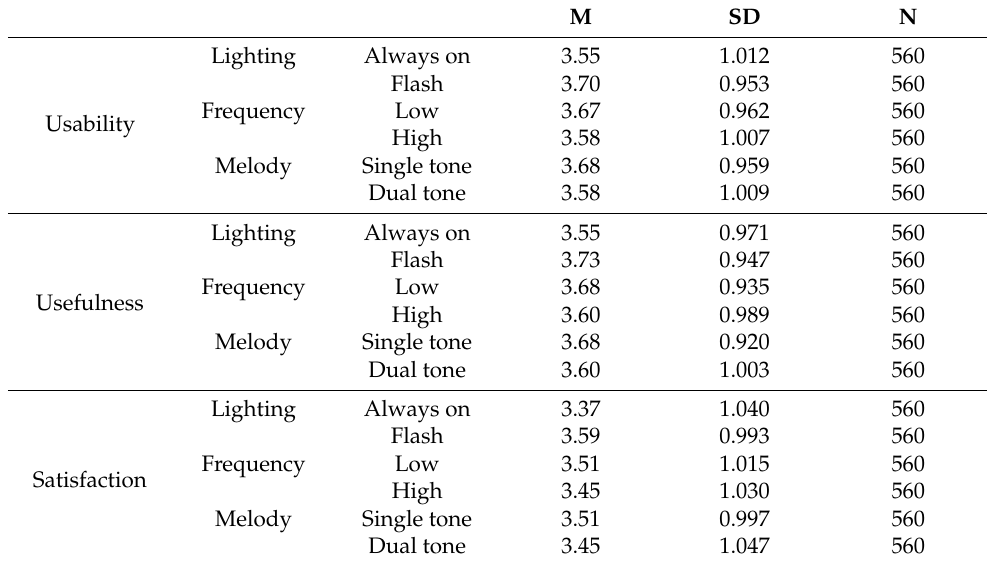
Table 15. Descriptive statistical averages of factors in waiting-to-restart